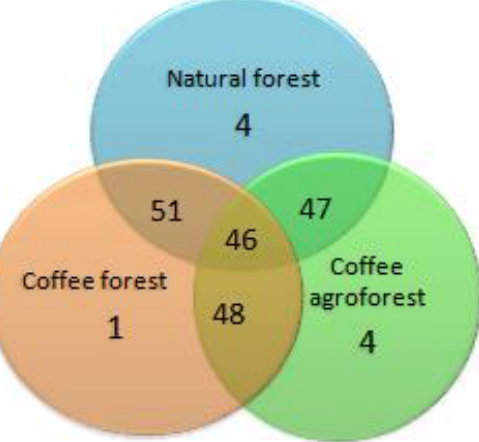
Figure 3. A Venn diagram showing woody species composition in the natural forest, coffee forest and coffee agroforest in Belete forest, southwest Ethiopia (natural forest = 57, coffee forest = 54, coffee agroforest = 53). Table 2. Sorensen and Multiple Site Similarity index of woody species among the natural forest, coffee forest and coffee